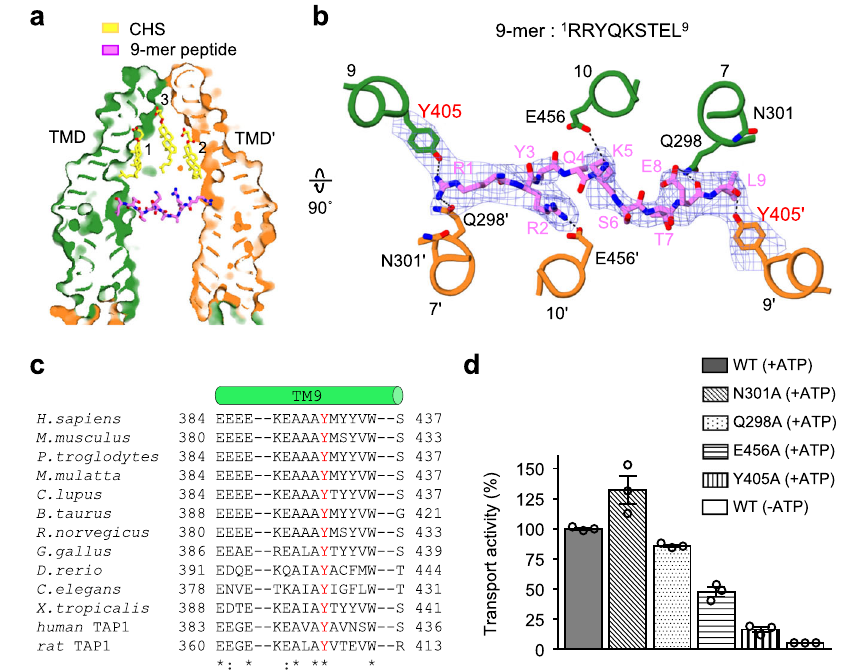
Fig. 4 | Peptide binding site. a Surface slab view of Δ TMD0 in the presence of 9-merpeptideandCHS.Boundpeptideinthecentralcavityisdepictedbytheviolet stick model and CHS in the upper cavity is represented by the yellow stick model. b Close-up view of the 9-mer peptide binding site. The residues interacting with bound peptides are shown in stick form. The EM density maps of the peptide and Y405 in each monomer are shown at the 4 σ level. The tyrosine residue and gluta- mine residue at positions 3 and 4 (Y3 and Q4), respectively, of the peptide, were